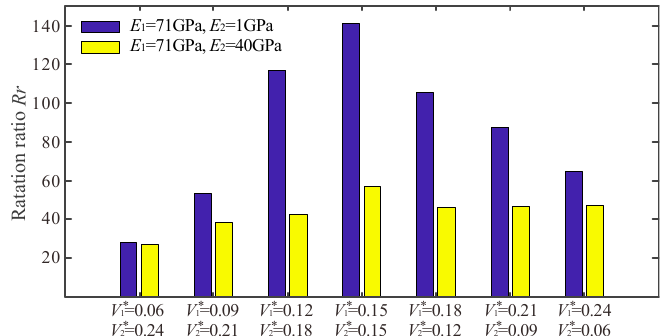
Figure 11. The rotation ratio R r for different volume fraction combinations.